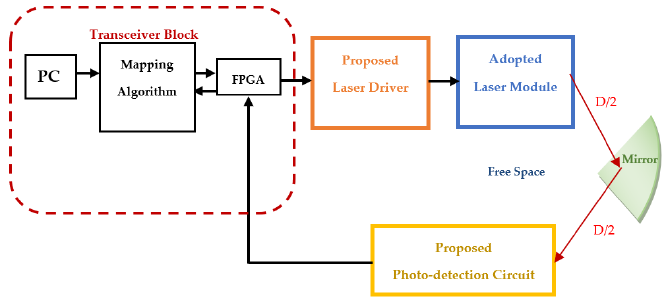
Figure 5. Laser Driver Circuit.